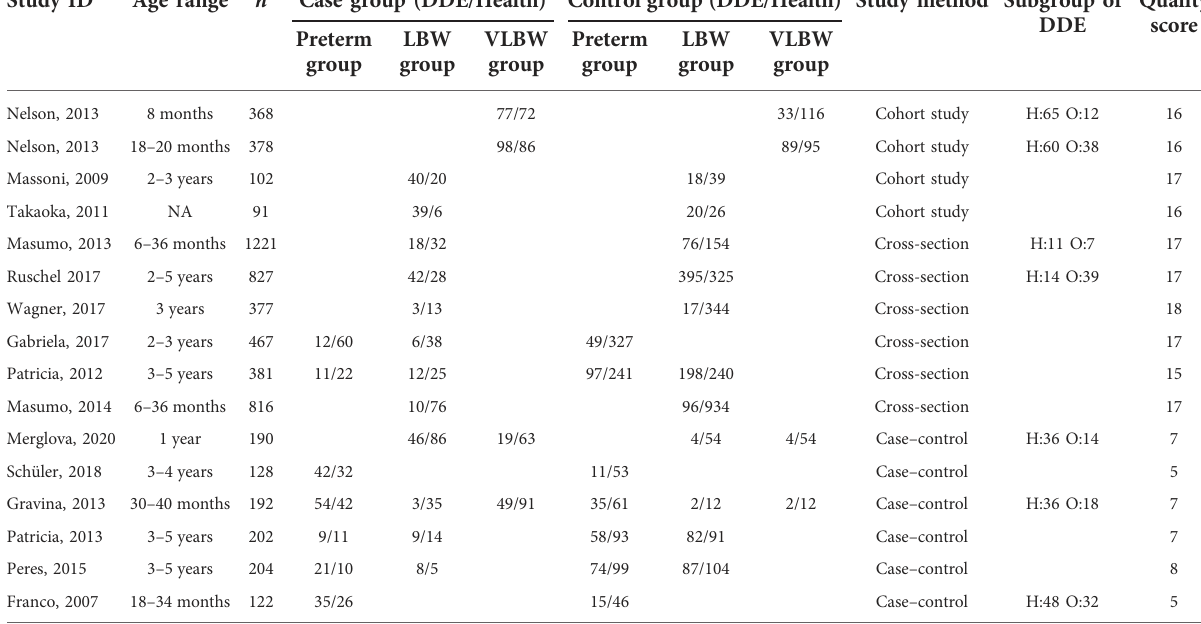
TABLE 1 The characteristics of the included studies.